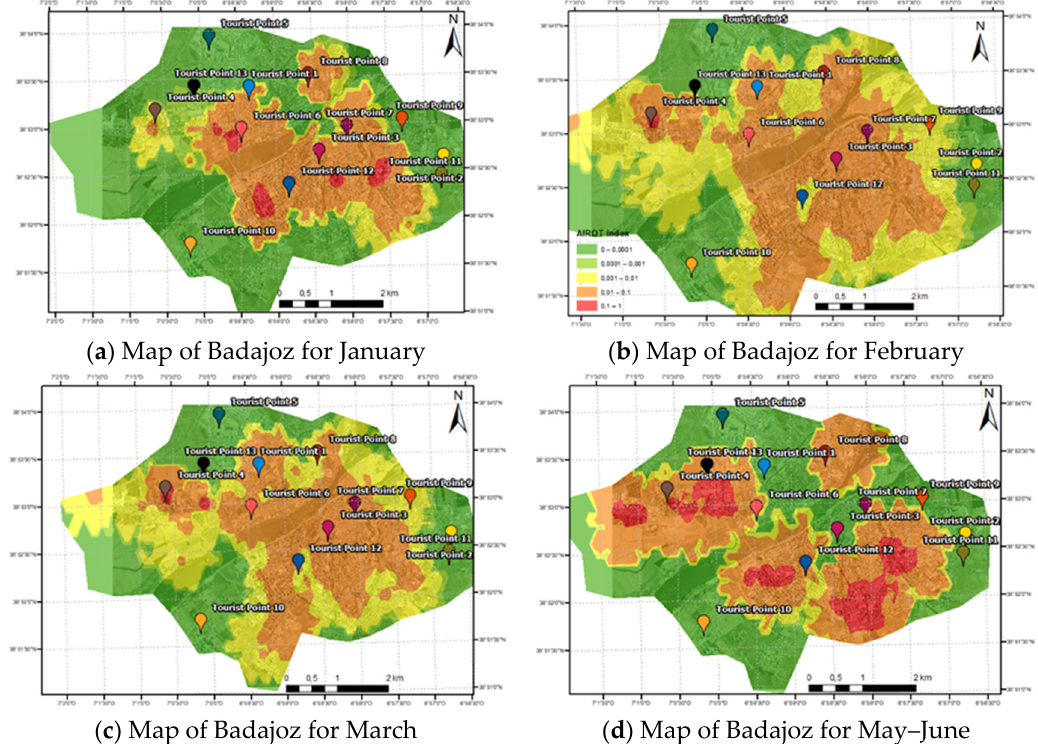
Figure 1. Tourist risk maps of Badajoz for the months of January ( a ), February ( b ), March ( c ) and May-June ( d ) according to the AIROT index and created using Kriging.